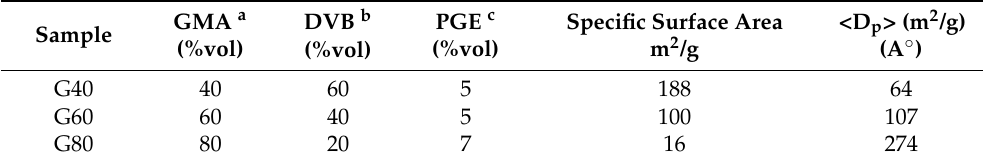
Table 1. Monomer and cross-linker relative content in the starting emulsion. Surface areas and average pore diameters <D p >, of the three matrices investigated.